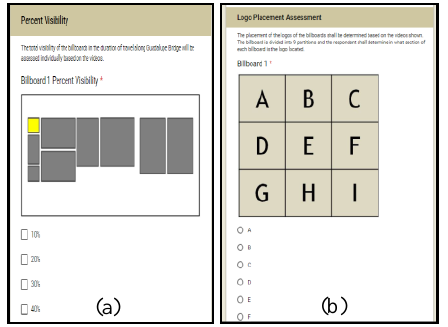
Figure 6: Validation surveys. (a) Percent Visibility Survey; (b)